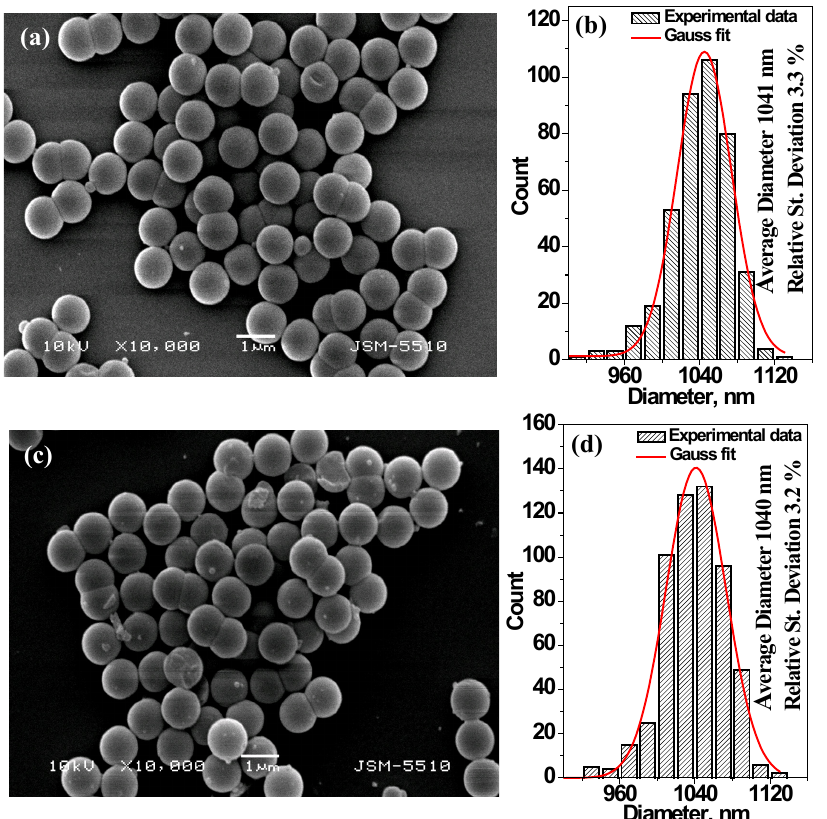
((a) and (b)) and µSiO @Cr(VI)-IIL ((c) and 2 2